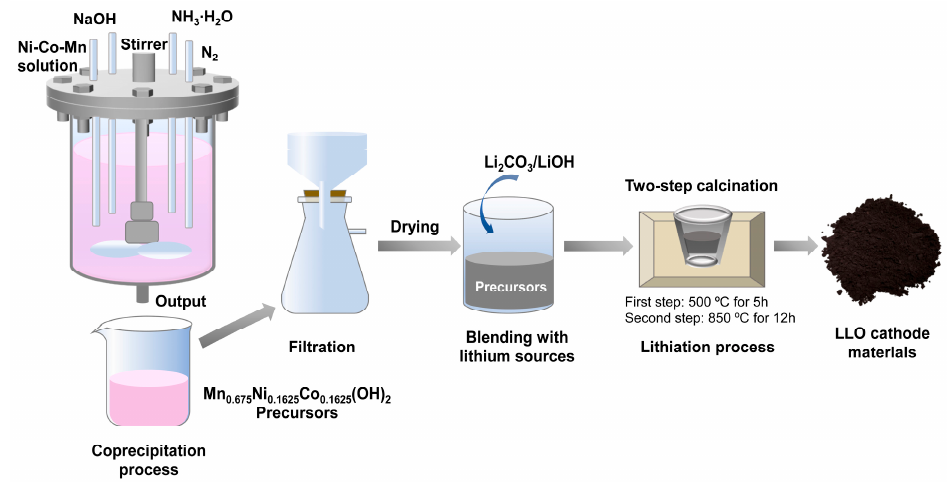
Figure 1. Schematic diagram of the synthesis of LLO cathode materials.